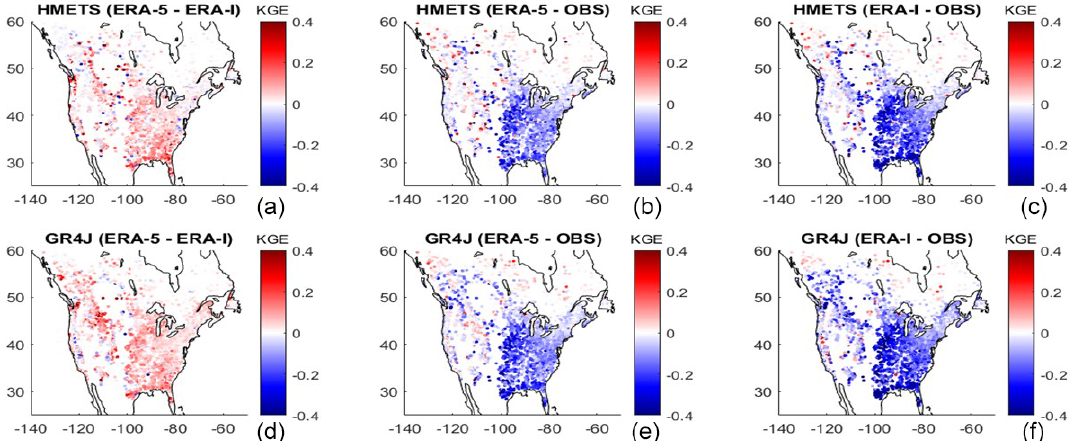
Figure 6. Spatial distribution of the difference of Kling–Gupta efficiency metrics between the three datasets for all 3138 watersheds, for the HMETS model (a, b, c) and GR4J model (d, e, f)